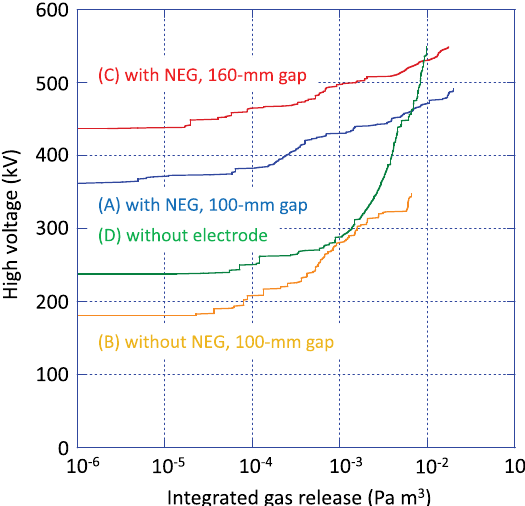
FIG. 2. High voltage as a function of integrated gas release during HV conditioning. The blue solid line labeled (A) was obtained with acceleration gap d ¼ 100 mm with NEG pumps placed around the gap. The orange solid line (B) was obtained with d ¼ 100 mm without NEG pumps. The red solid line (C) was obtained with d ¼ 160 mm with NEG pumps. The green solid line (D) was obtained without a cathode electrode. The initial condition of the HV chamber and ceramic insulator prior to HV conditioning was similar to each other, because the same baking procedure was performed for each configuration. The same cleaning technique of HV chamber was used for (A), (B), and (C), as described in